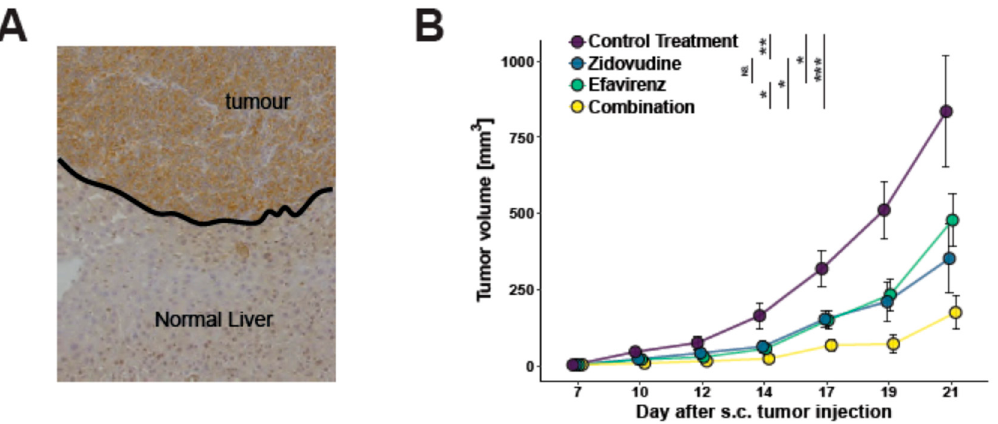
Figure 4. ( A ) Increased LINE1 staining of murine colorectal MC38 tumors growing as colorectal liver metastases compared to adjacent normal liver tissue. ( B ) Decreased tumor growth of s.c. injected MC38 cells in C57/Bl6 mice treated with either Zidovudin or Efavirenz. Note the synergistic effect of combination treatment resulting in strongly decreased tumor growth. * p < 0.05, ** p < 0.01, *** p < 0.005.